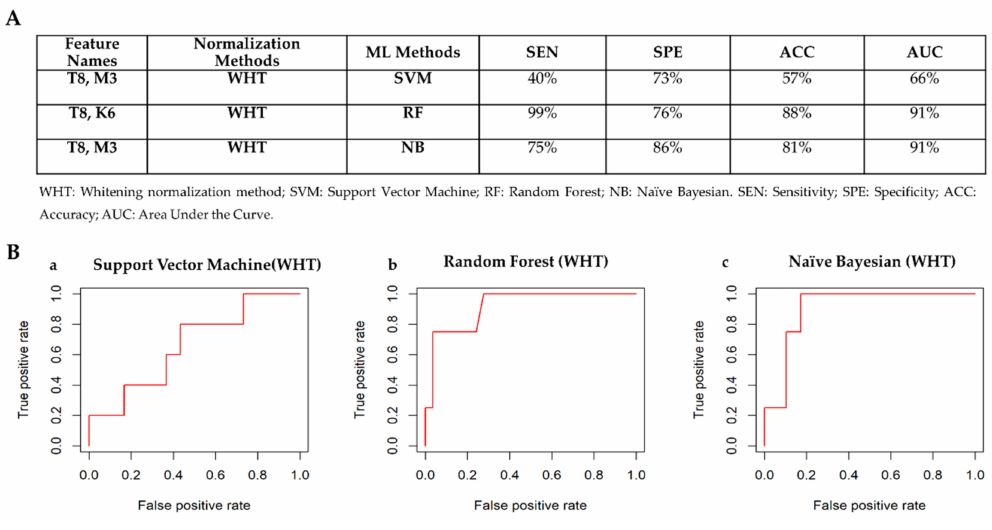
Figure 9. Classifiers’ performance to detect HER2 receptor status. ( A ) Comparison table among classifiers: HER2 + vs HER2–. ( B ) ROC curves for the best classifiers to automatically detect HER2 receptor status. Radiomic Feature normalized by whitening methods were considered for the classification task. a) Best classifier for Support Vector Machine Method. b) Best classifier for Random Forest Method. c) Best classifier for Naïve Bayesian